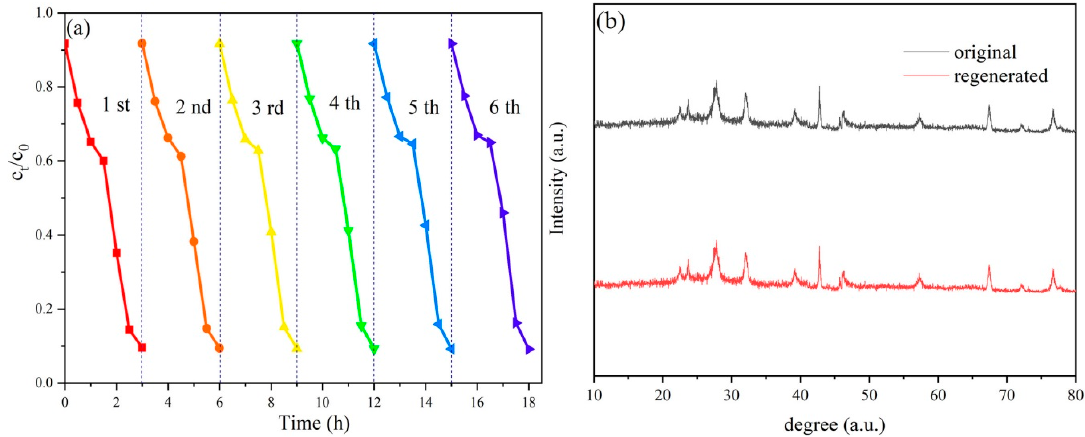
Figure 9. ( a ) The sixth repetition photocatalytic activities experiment of AgI/MFeO 3 /g-C 3 N 4 and ( b ) XRD patterns of fresh and used AgI/LaFeO 3 /g-C 3 N 4 . ( b ) XRD patterns of fresh and used AgI / LaFeO